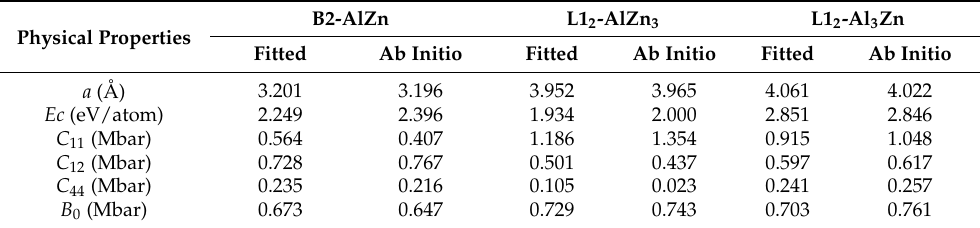
Table 3. The physical properties of the Al-Zn intermetallic compounds fitted using the potential and calculated from ab initio .